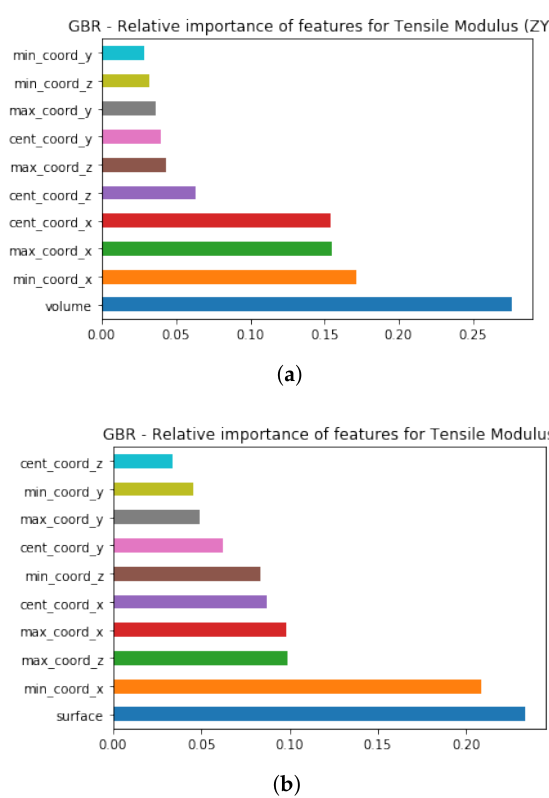
Figure 7. Feature relative importance based on the specimen orientations ( a ) Tensile Modulus—ZYX orientation. ( b ) Tensile Modulus—All